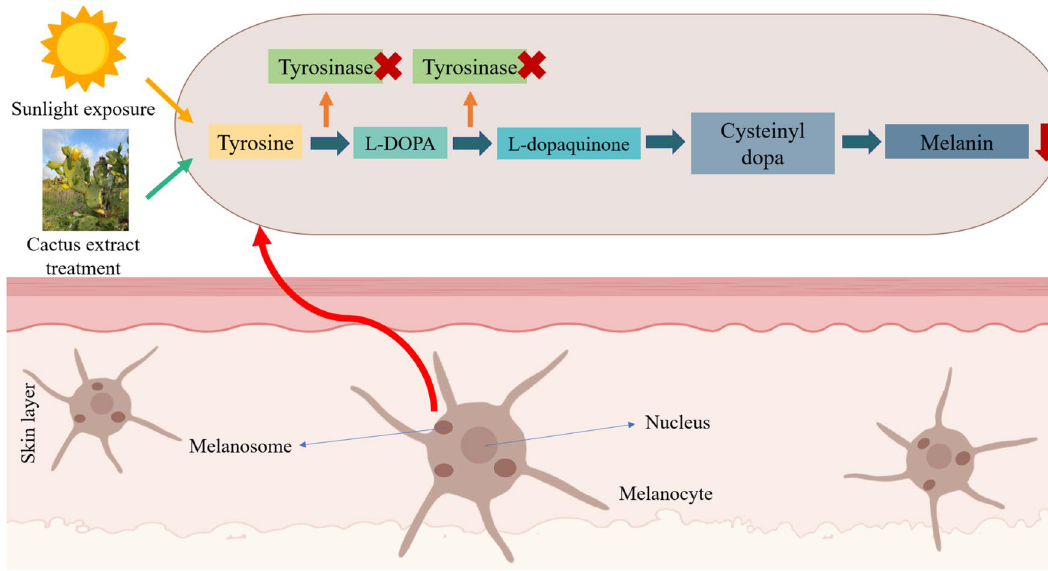
Figure 10. Inhibitory effects and mechanism of cactus extract on melanin